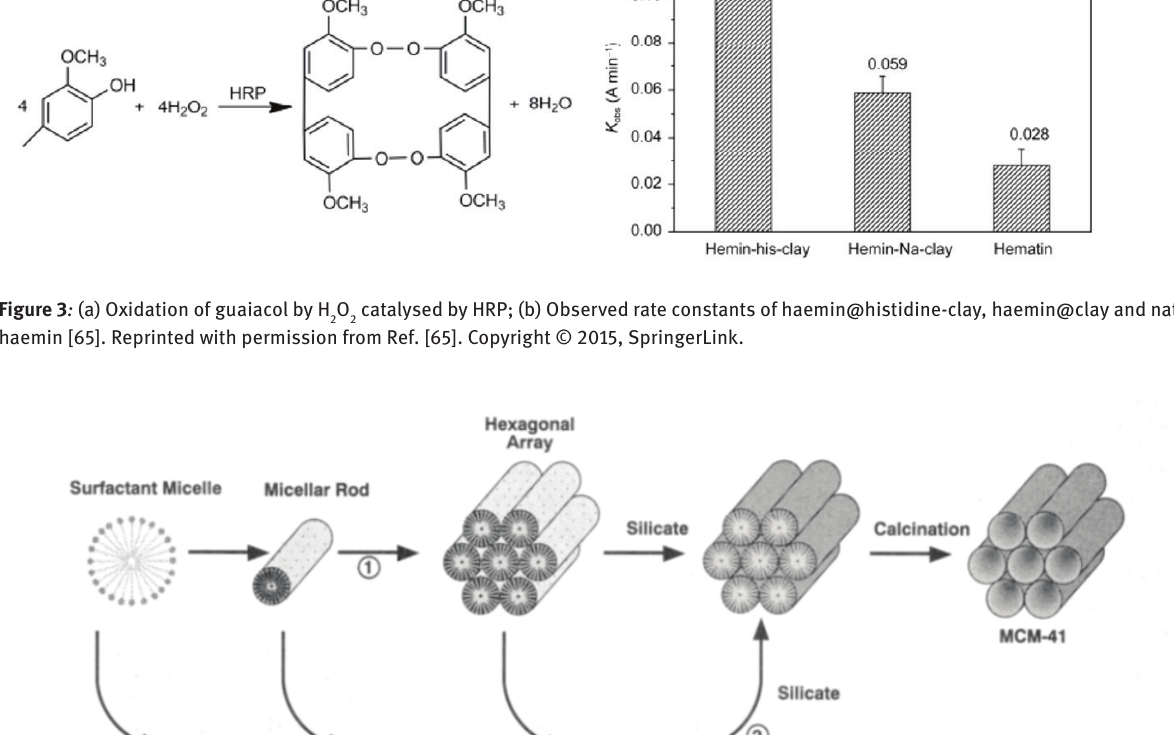
Figure 4: Mechanism of formation and structure of MCM-41 [66]. Reprinted with permission from Ref. [66]. Copyright © 1992, American Chemical